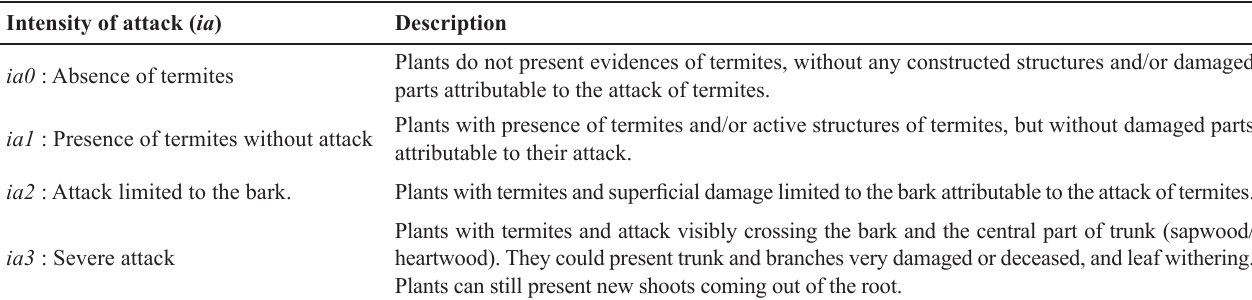
Table 1. Categories of attack intensity by termites on the Cerrado plants in the Estação Ecológica de Pirapitinga - Minas Gerais. Adapted from Anonymous